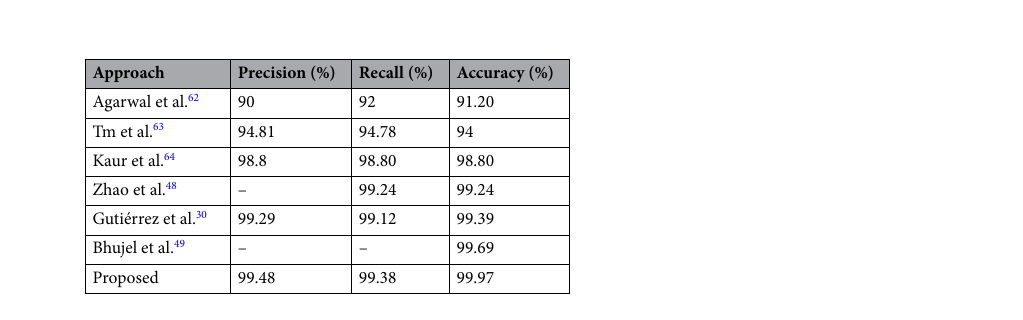
Table 6. Performance analysis with the latest